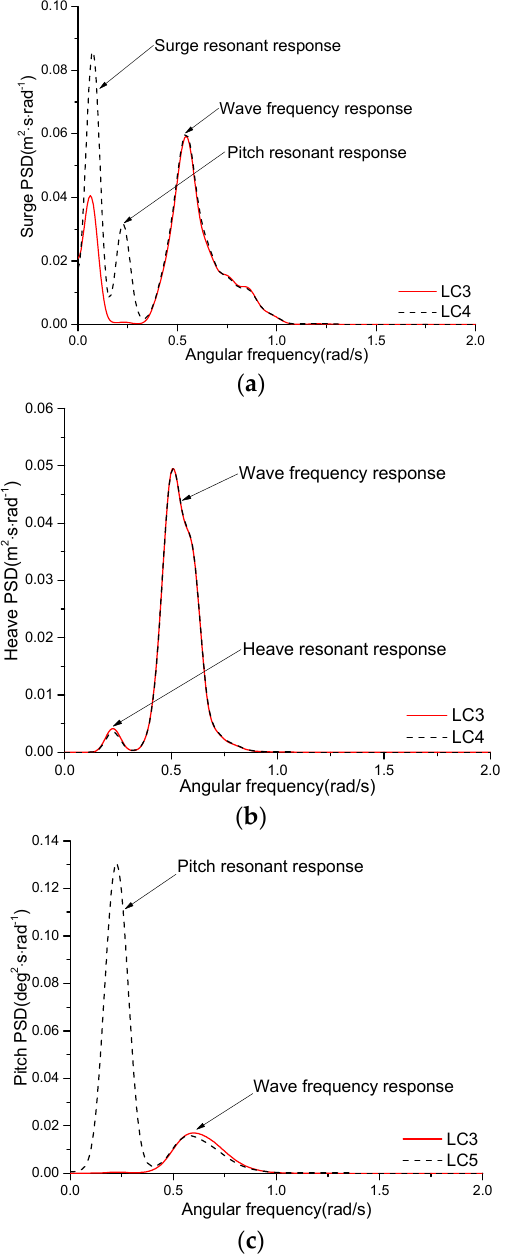
Figure 10. Comparison of power spectra of motion responses for the rated and over-rated wind speeds. ( a ) Power spectra of surge motion; ( b ) power spectra of heave motion; ( c ) power spectra of pitch motion. Comparison of Motion Responses of the 10 MW FOWT for the Steady and Turbulent